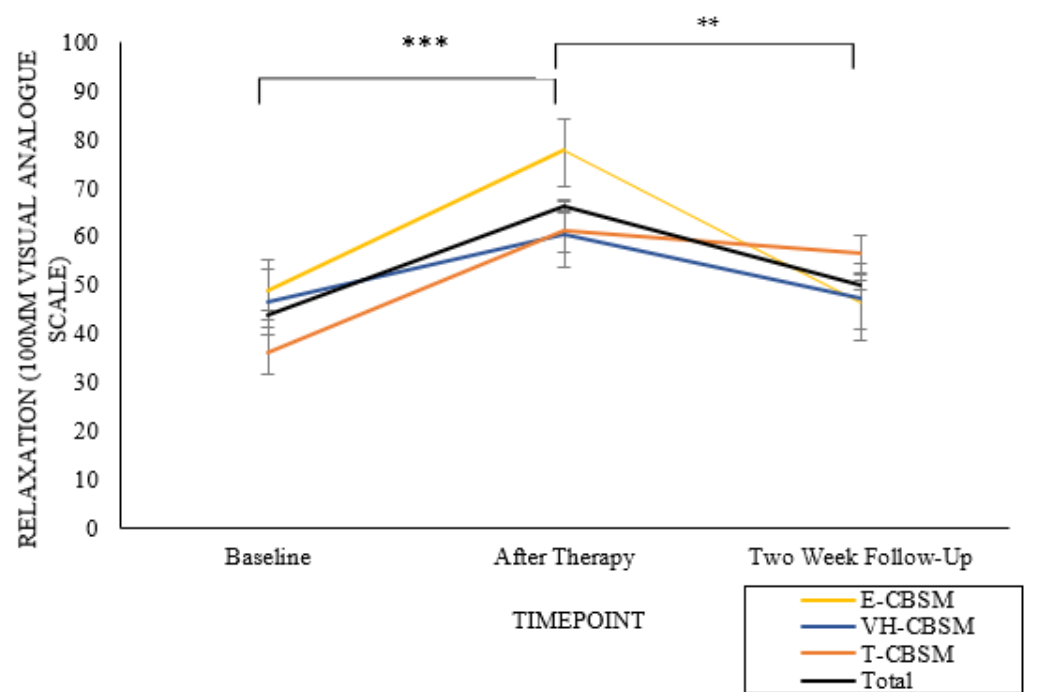
Figure 3. A significant increase in relaxation from baseline to after the therapy session. Note, mean scores and standard error bars are depicted (*** p < 0.001, ** p <